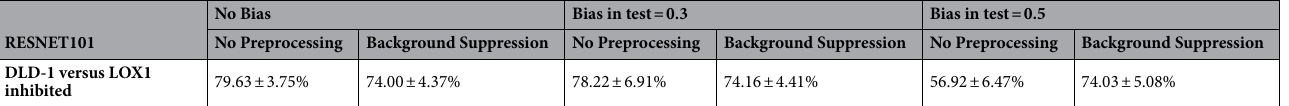
Table 3. Accuracy classification results for No Bias condition (first column), bias value equal to 0.3 (second column), bias value equal to 0.5 (third column), using RESNET101 and SVM classifier.